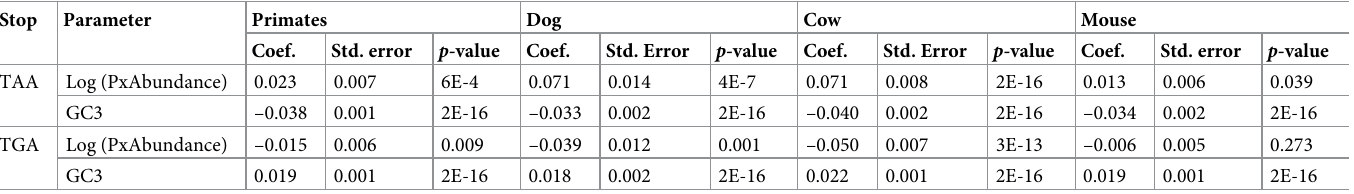
Table 1. Results from multivariate logistic regression analysis that assess the extent to which gene expression and gene coding sequence GC content can predict stop codon usage in mammalian genes. Stop Parameter Primates Dog Cow Mouse Coef. Std. error p -value Coef. Std. Error p